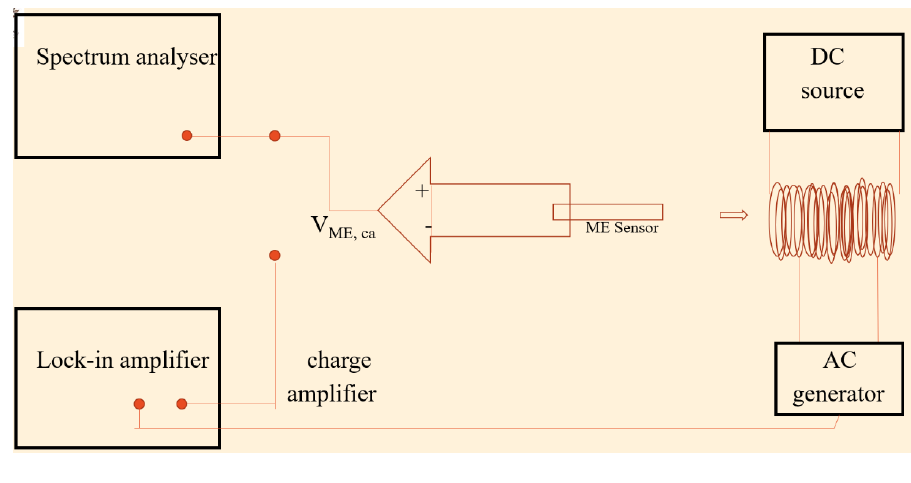
Figure 6. Schematic diagram of the cluster of instruments used to find the magnetically induced magnetoelectric coupling coefficient. Adapted from Reference [77].